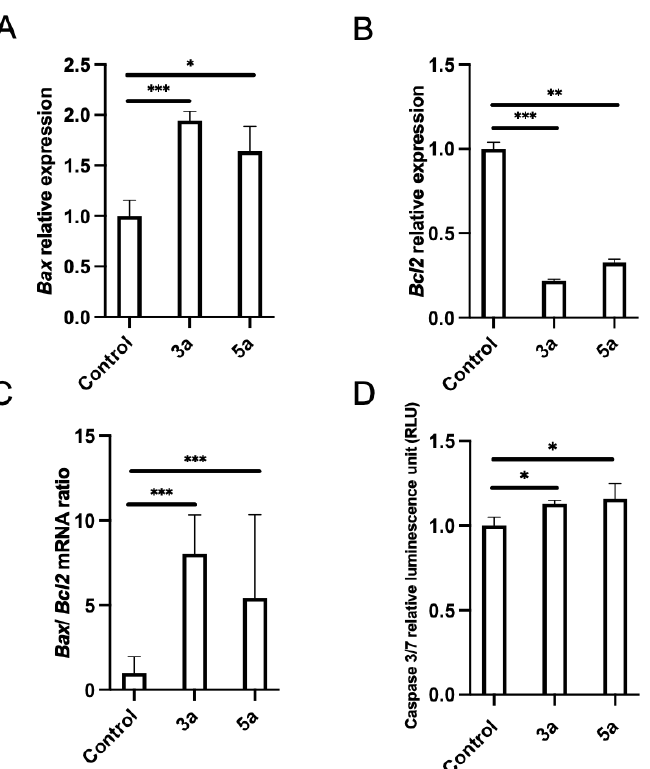
Figure 5. Effect of chalcone methoxy derivatives on the levels of apoptotic markers in Luc-4T1 cells. The cells were cultured with 10 µg/mL of compound 3a , compound 5a , or a control vehicle for 24h, and then either RNA extraction or the Caspase-Glo 3/7 assay was performed. The relative transcription levels of ( A ) Bax , ( B ) Bcl2 , and ( C ) Bax / Bcl2 mRNA ratio were determined. Gene expression levels were normalized to Hprt . ( D ) Caspace 3/7 relative luminescence. Bars represent the mean ± SD of four replicates from two independent experiments. * p < 0.05, ** p < 0.01, and *** p < 0.001 represent a statistical